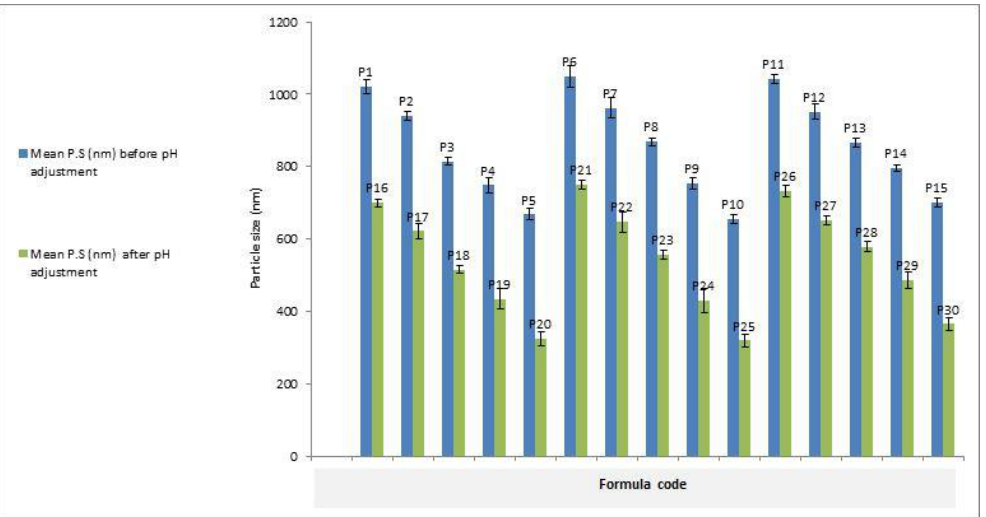
Fig.1. Effect of pH change of chitosan and TPP solutions on the particle size of drug-free